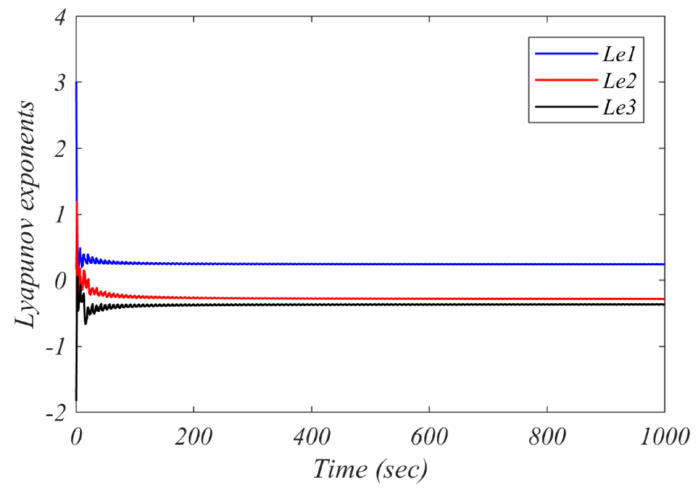
Figure 5. Lyapunov exponents corresponding to time.